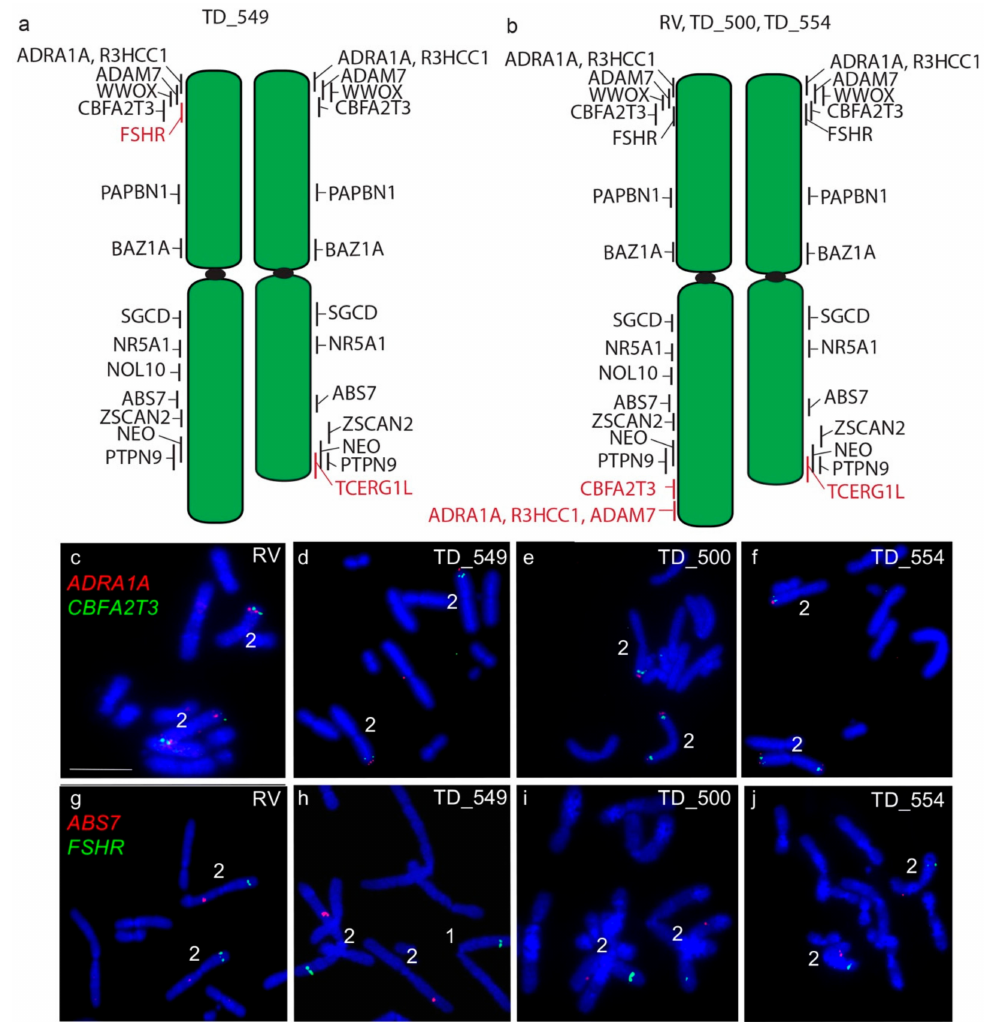
Figure 3. Cytogenetic maps of Chromosome 2 ( a ) TD_549 ( b ) RV, TD_500 and TD_554. Genes indicated in red di ff er in copy number between the two copies of chromosome 2. Flpter values ( ± 1 standard deviation) are indicated by vertical lines beside chromosomes. ( c – f ) In RV, TD_500 and TD_554, ADRA1A (red) and CBFA2T3 (green) are duplicated, mapping to both ends of one copy of chromosome 2, but have not been duplicated in TD_549. ( g – j ) In RV, TD_500, and TD_554, FSHR (green) and ABS7 (red) are located on the short and long arms respectively of both chromosome 2 homologues. In TD_549, one copy of FSHR has translocated to the short arm of chromosome 1 Scale bar represents 10 µ